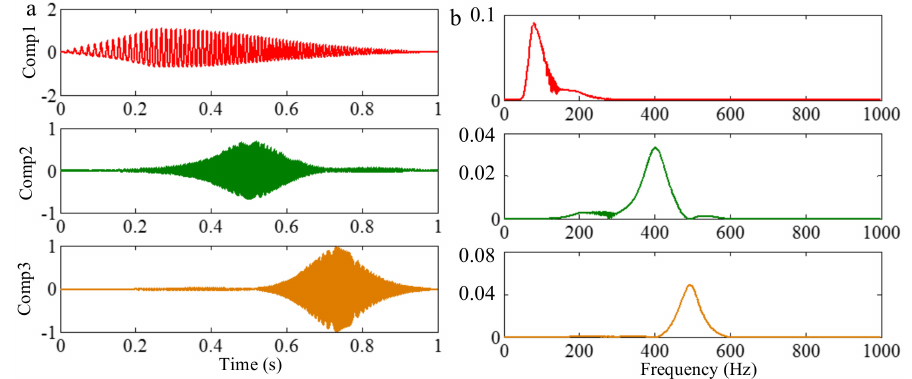
Figure 35. The decomposition result of f sig 6 by using VMD: ( a ) the waveform and ( b ) the Fourier spectrum.